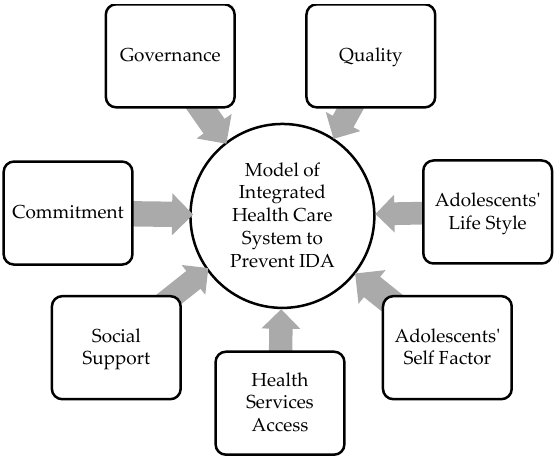
Figure 1. Model of integrated health care system to prevent IDA.